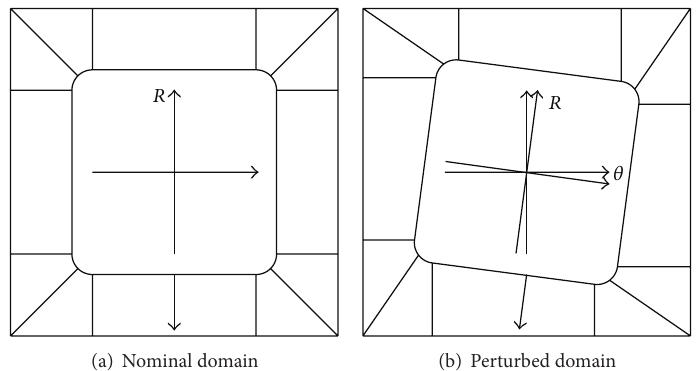
Figure 1: Two realisations of the domain with meshes. The nominal domain is the reference. The rotation and scaling of the cavity as well as the direction of the uncertainty in the Young’s modulus is